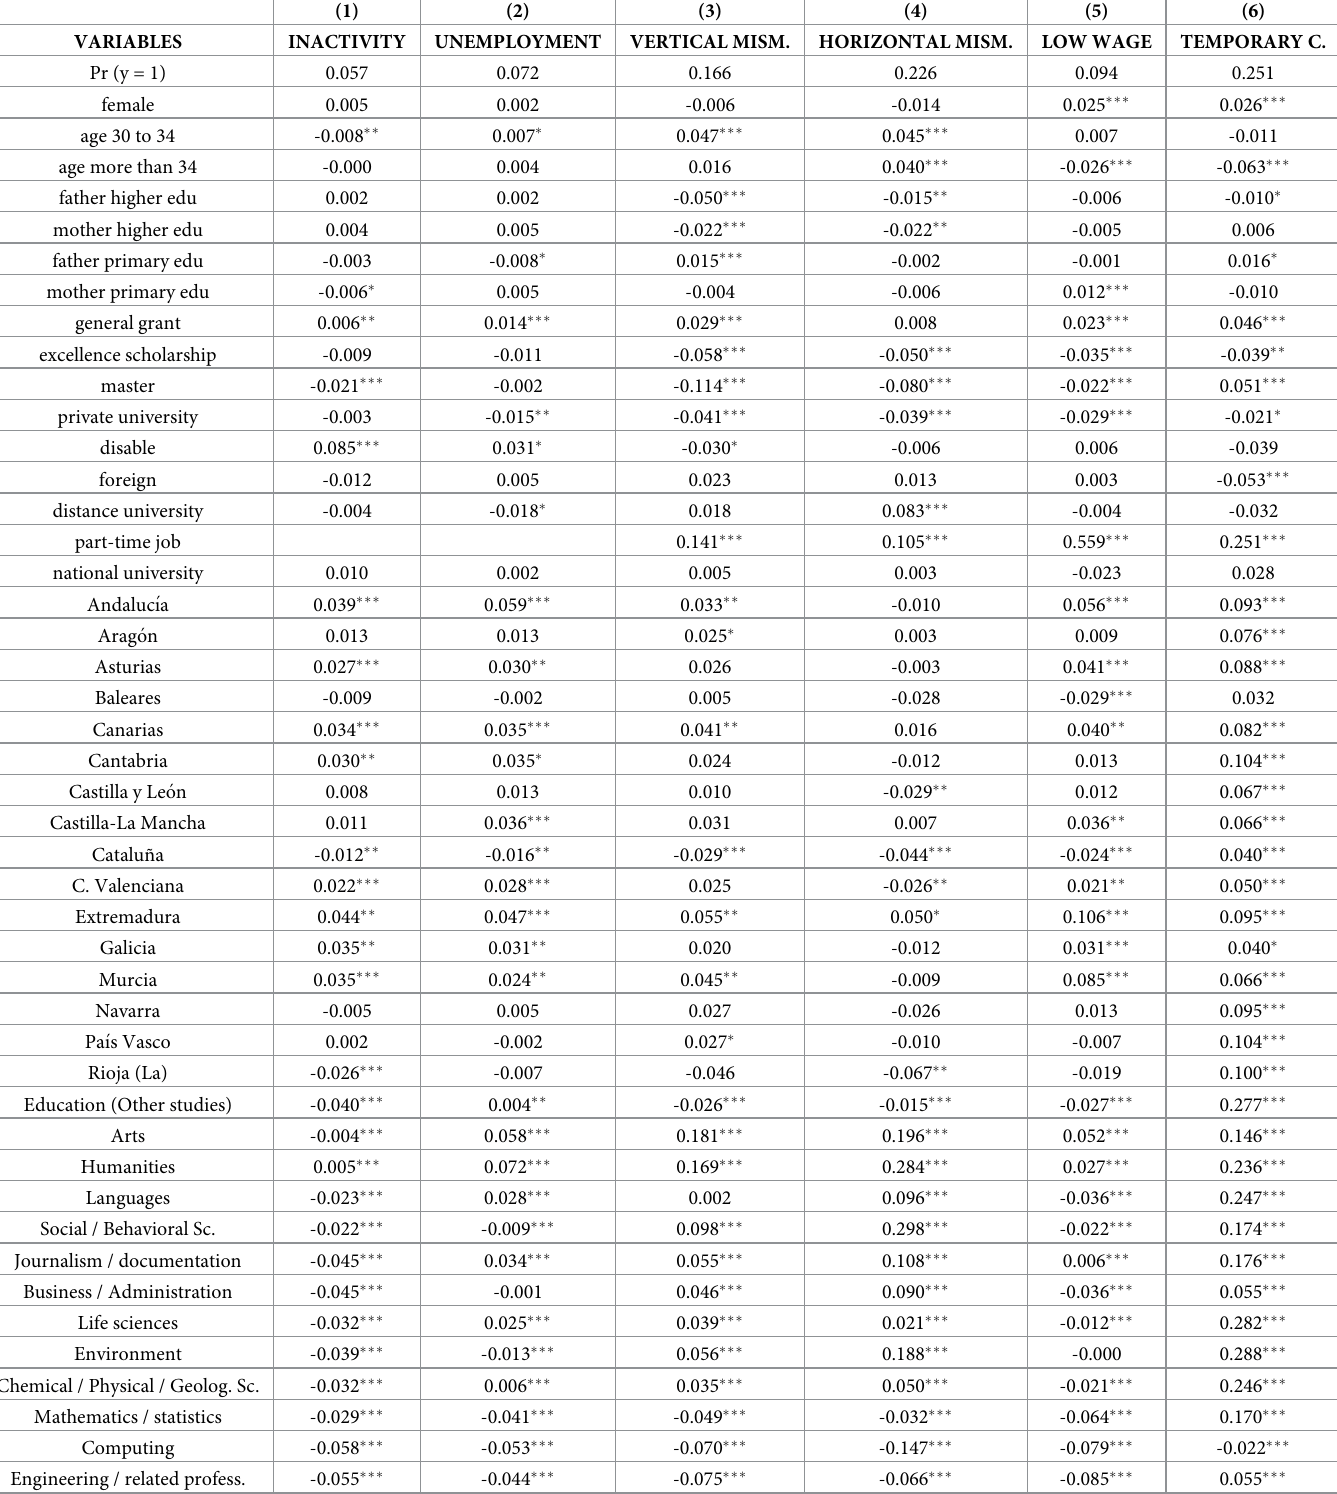
Table 3. Marginal effects after probit (Bachelor